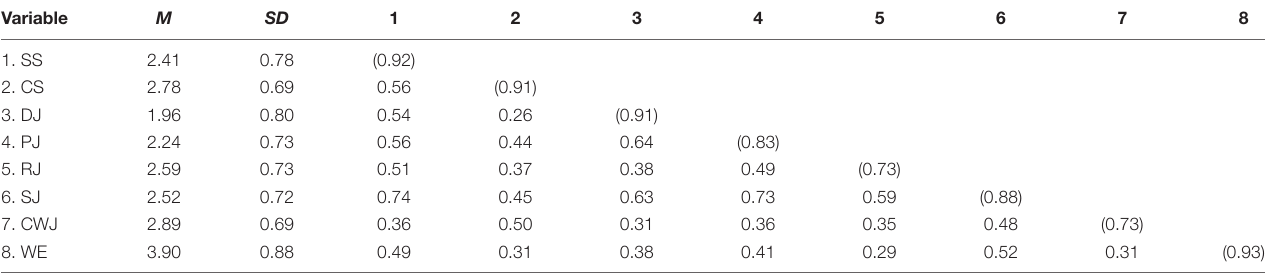
TABLE 2 | Means (M), standard deviations (SD), and correlations (r) for study variables. Variable M SD